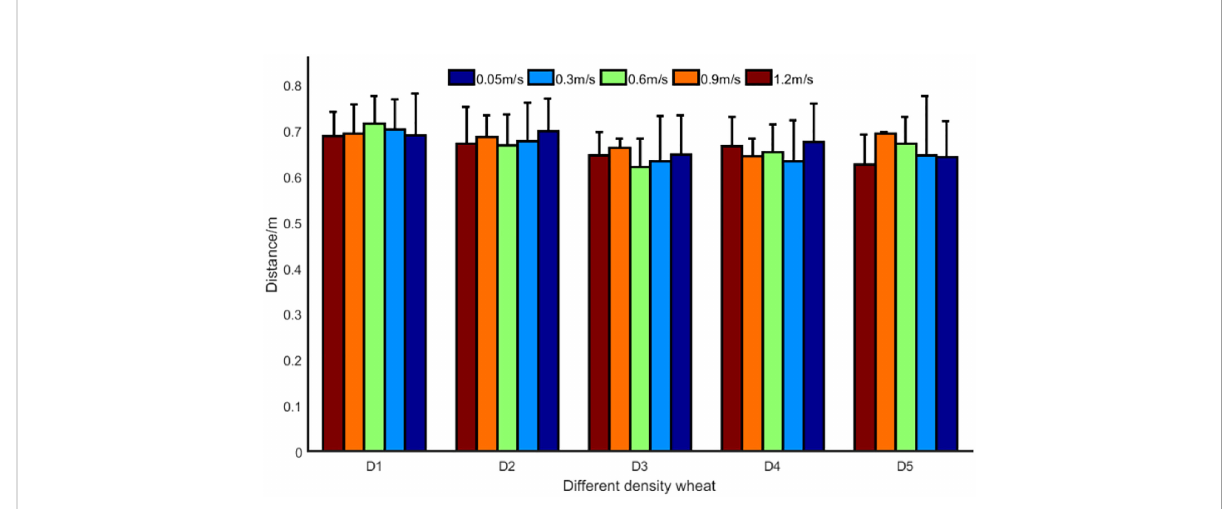
FIGURE 22 Detection results of ultrasonic sensors on wheat canopy. The thinner the canopy, the greater the detection error.